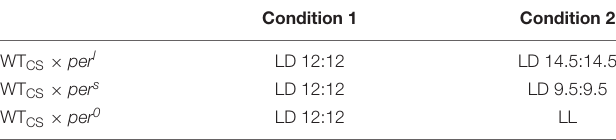
TABLE 1 | Experimental settings of long-term competition experiments.